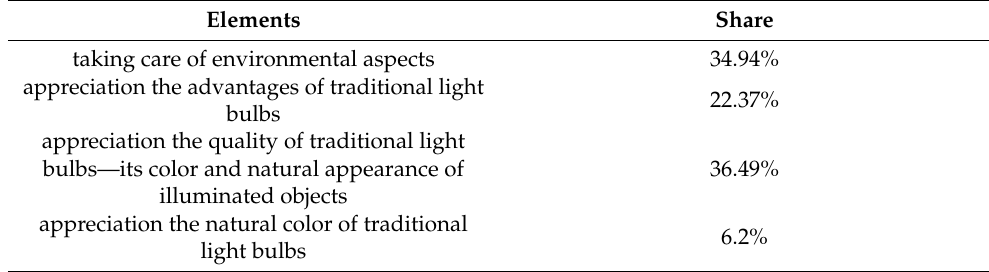
Table 2. Decisive elements of a light source.